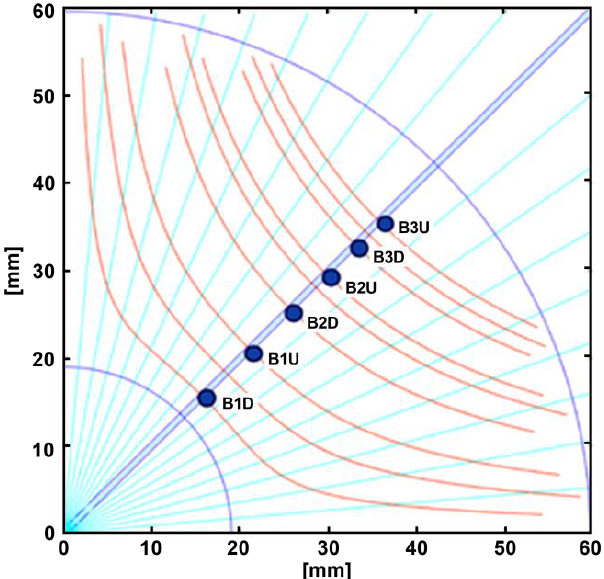
Figure 5. Lines defining the 3 barriers (red) and the end points (blue) of the ribs, initially set at 1 mm width.